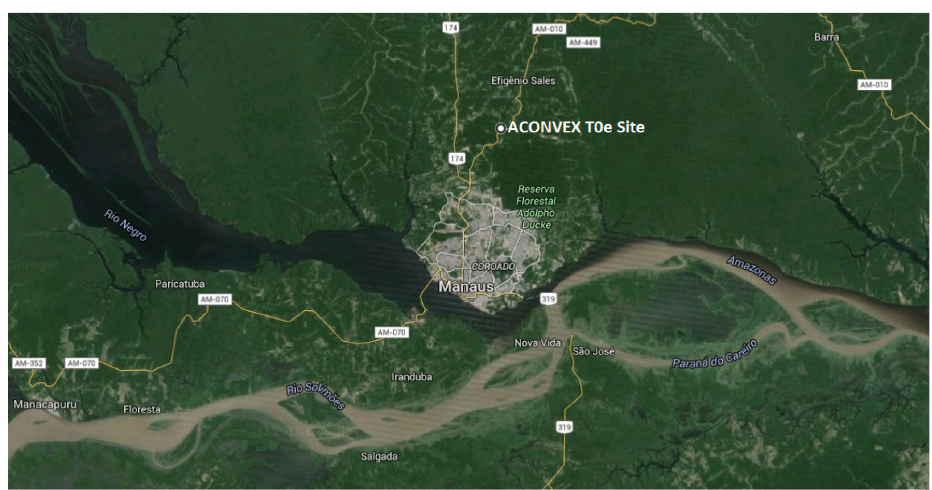
Figure 1. Satellite-based map (Google Earth) showing the location of the lidar site (ACONVEX T0e; 2.89 ◦ S 59.97 ◦ W), 30km upwind (north) from downtown Manaus-AM,